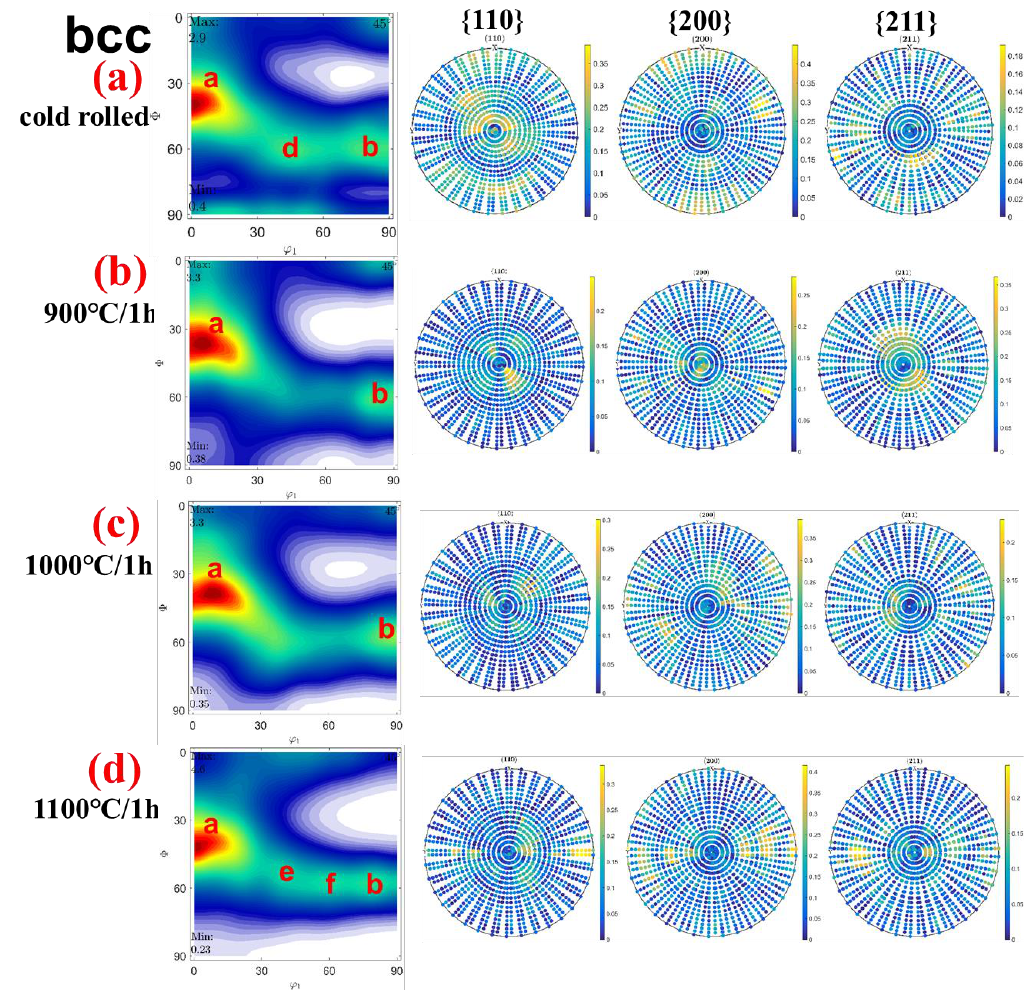
Figure 5. The orientation distribution functions (ODFs) and the difference between the calculated ODFs and the raw data in the pole figure of the bcc phase in the HEA, annealed at ( a ) cold-rolled, ( b ) 900 °C/1 h, ( c ) 1000 °C/1 h, and ( d ) 1100 °C/1 h. Note that φ 2 = 45°.